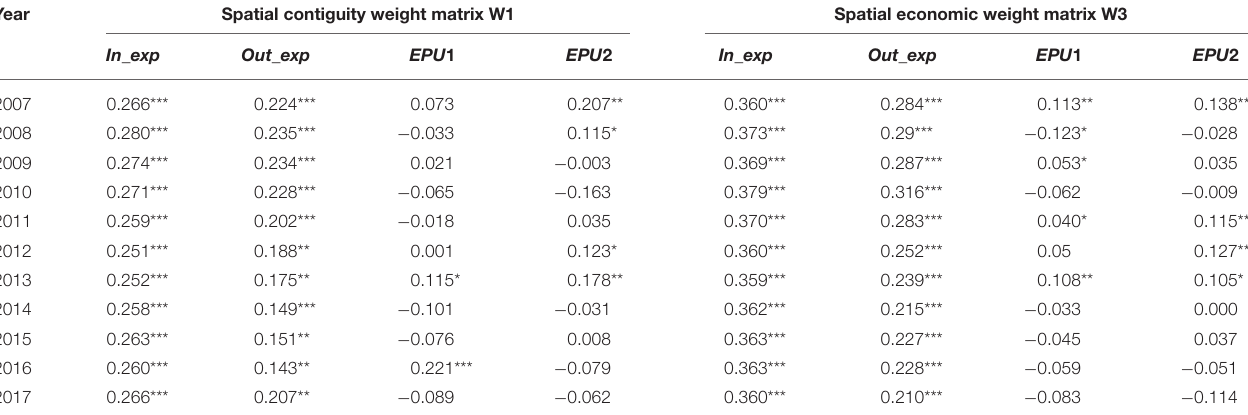
TABLE 4 | Global moran index values of healthcare expenditure and EPU.